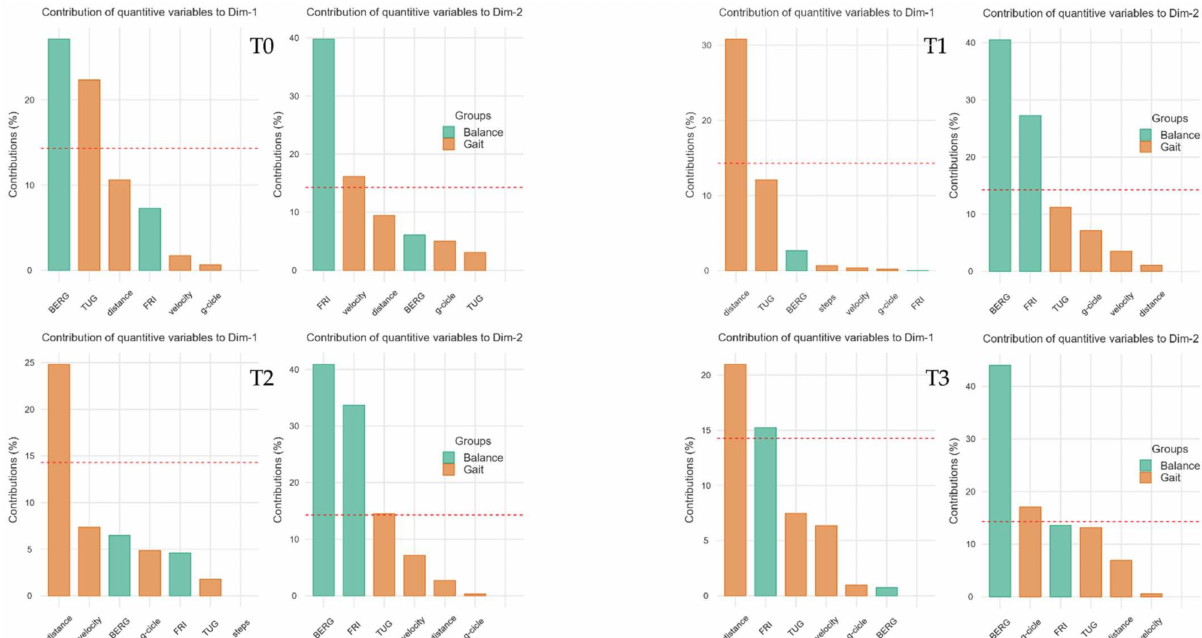
Figure 4. Contributions to the dimension graphs (Cartesian axes). The single weight of each variable in the construction of the Dim1 (abscissa axes of previous figure) and Dim2 (ordinate axes of previous figure) is graphed by bar plots. Abbreviations: BERG: Berg Balance Score; Dim1: dimension 1 (abscissa axis); Dim2, dimension 2 (ordinate axis); g-cycle: gait cycle; TUG: timed up-and-go; FRI: Fall Risk